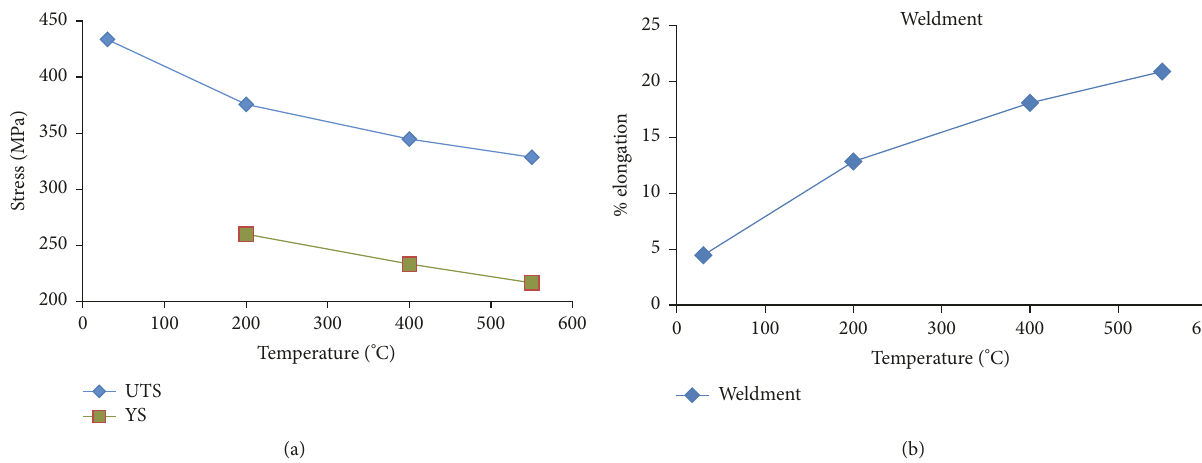
Figure 9: Behaviour of the weldment at different operating temperature. (a) UTS and YS. (b) % elongation.